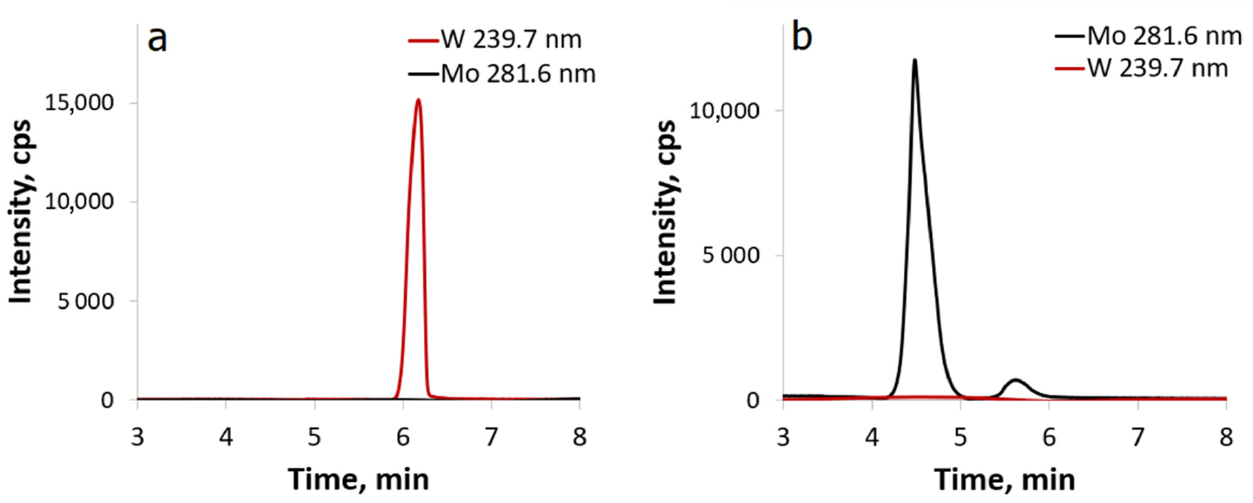
Figure 5. HPLC-ICP-AES chromatograms of ( a ) [SiW 12 O 40 ] 4 − and ( b ) [ β -Mo 8 O 26 ] 4 − in dimethyl sulfoxide. Figure 5. HPLC ‐ ICP ‐ AES chromatograms of ( a ) [SiW 12 O 40 ] 4 − and ( b ) [ β‐ Mo 8 O 26 ] 4 − in dimethyl sulfoxide. The HPLC-ICP-AES chromatogram of (Bu 4 N) 4 [ β -Mo 8 O 26 ] in DMSO (Figure 5b) The HPLC ‐ ICP ‐ AES chromatogram of (Bu 4 N) 4 [ β‐ Mo 8 O 26 ] in DMSO (Figure 5b) is